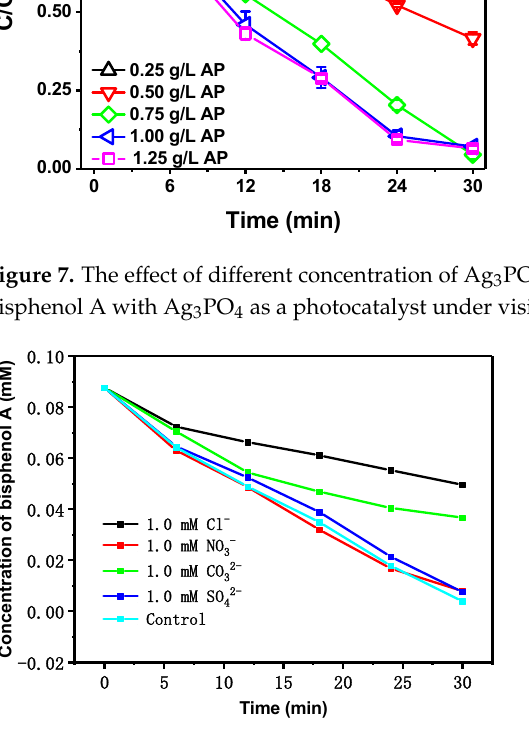
Figure 8. The effect of different anions on the degradation efficiency of bisphenol A with Ag 3 PO 4 and potassium persulfate as photocatalysts under visible light